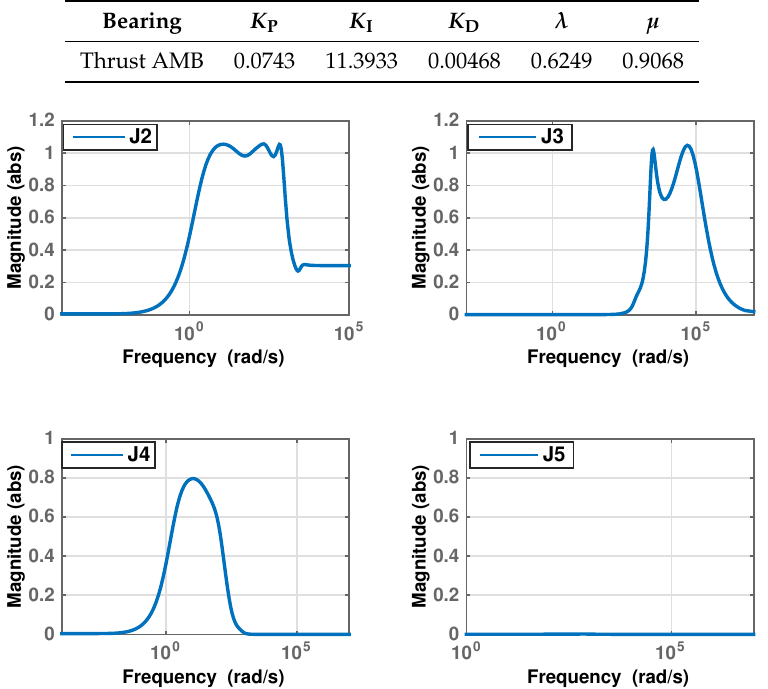
Table 8. The tuned FOPID controller parameters for rotor axial dynamics.